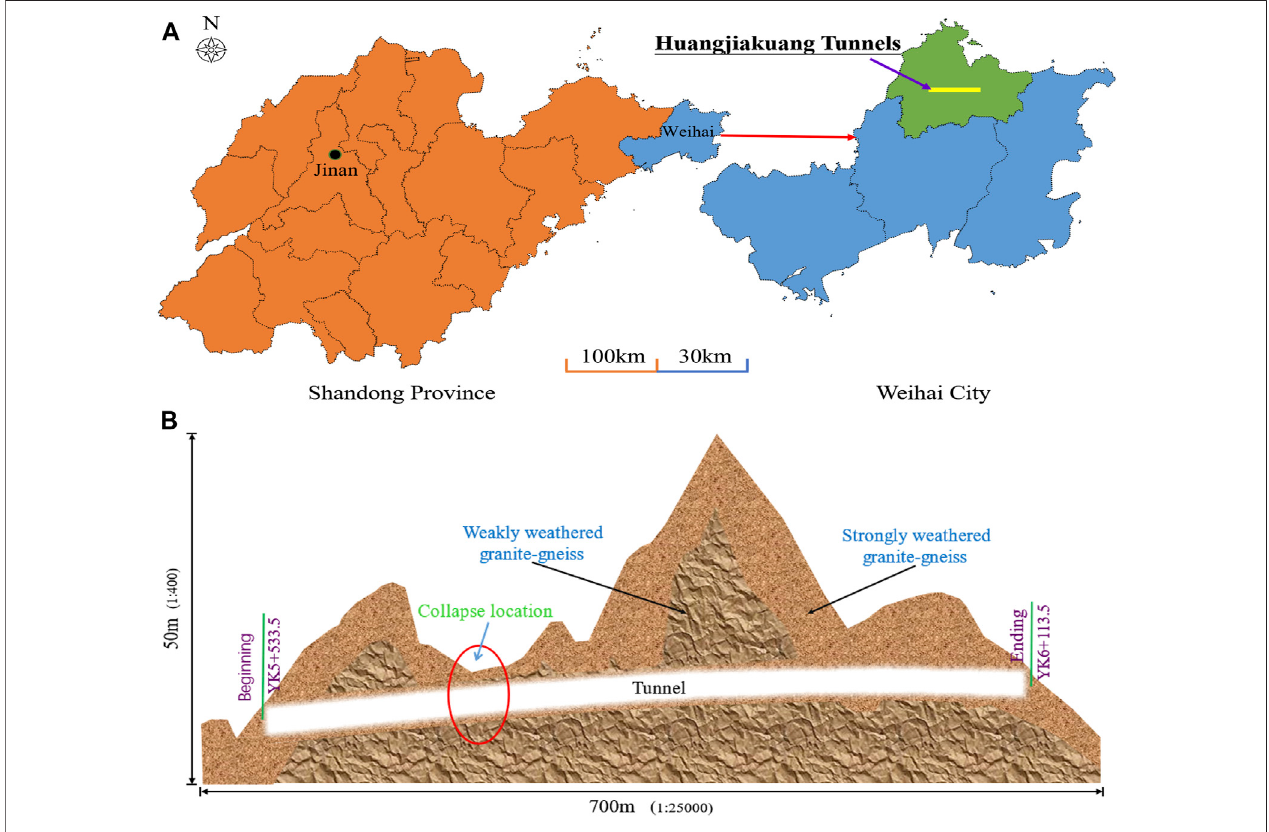
FIGURE 1 | Speci fi c information of Huangjiakuang tunnels. (A) Geographic location of Huangjiakuang tunnels in Weihai City, Shandong Province, China. (B) Collapse location longitudinal section of the Huangjiakuang right tunnel.